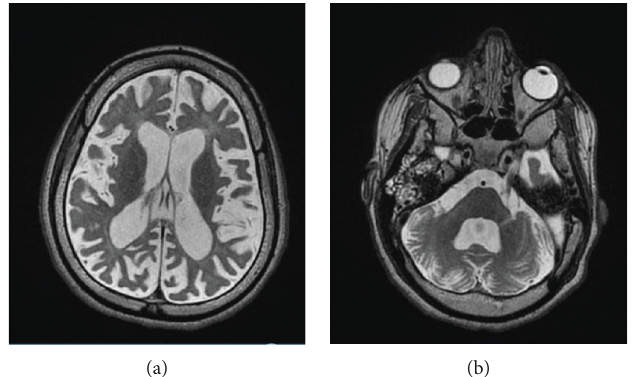
Figure 1: Axial T2 sequences (a) showing extensive cortical atrophy and ventriculomegaly ex-vacuo (b) at the level of the pons, showing an enlarged fourth ventricle and cerebellar cortical atrophy.